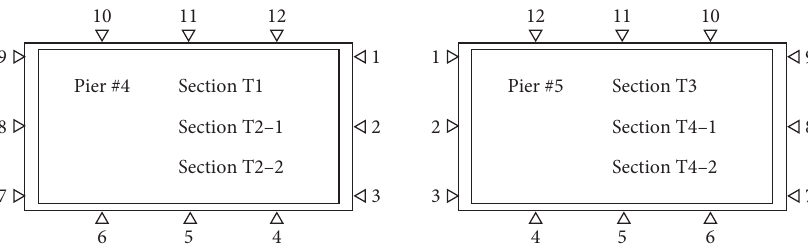
Figure 5: Layout diagram of the stress measuring points of the tower column test